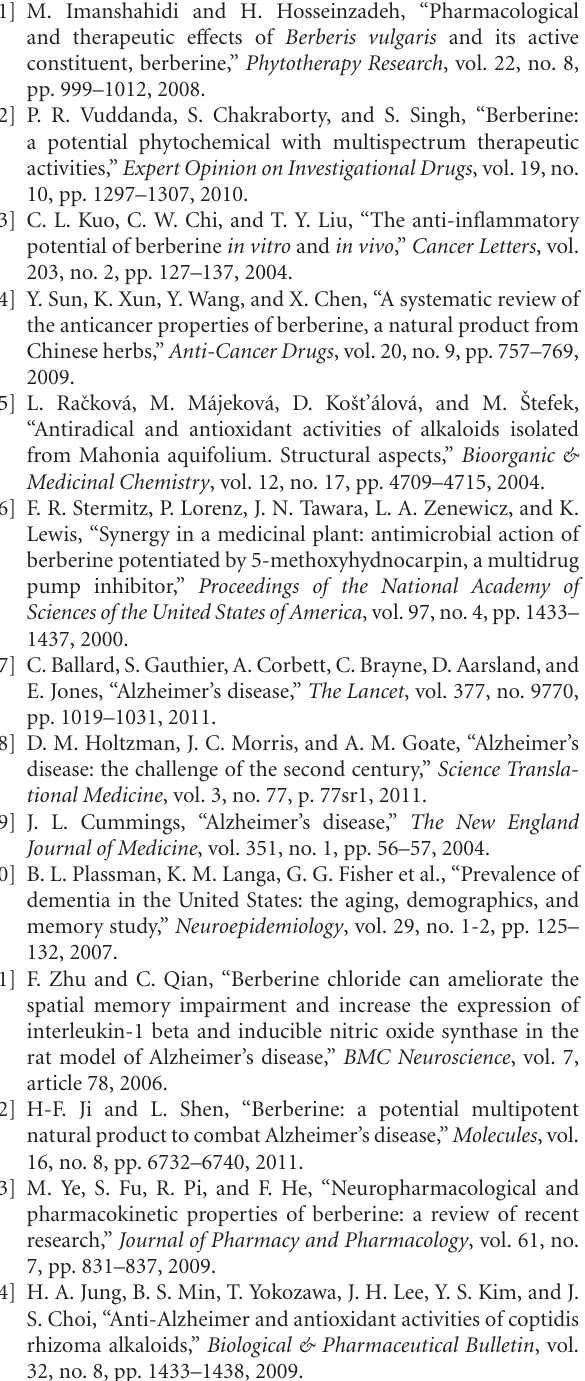
Table 1: Theoretically estimated binding constants ( K d ) of berber- ine with AChE, BChE, MAO-A, and MAO-B, and experimental IC 50 . Targets Theoretical K d ( µ M) Experimental IC 50 ( µ M) AChE 0.66 0.44 [14], 0.58 [15], 0.37 [16] BChE 3.31 3.44 [14] MAO-A 105.2 126 [19] MAO-B 66.0 98.2 [20], 98.4